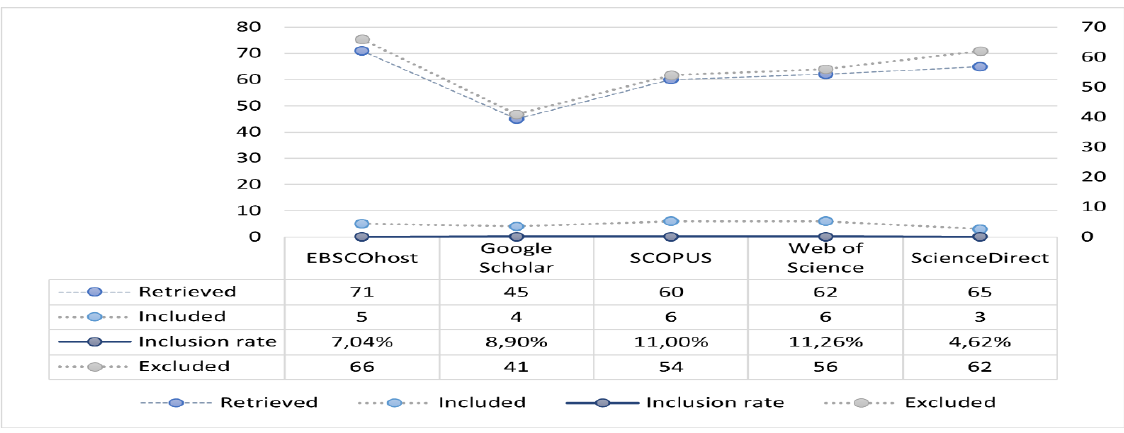
Table 2: Articles Extracted, Excluded and Included from each Database